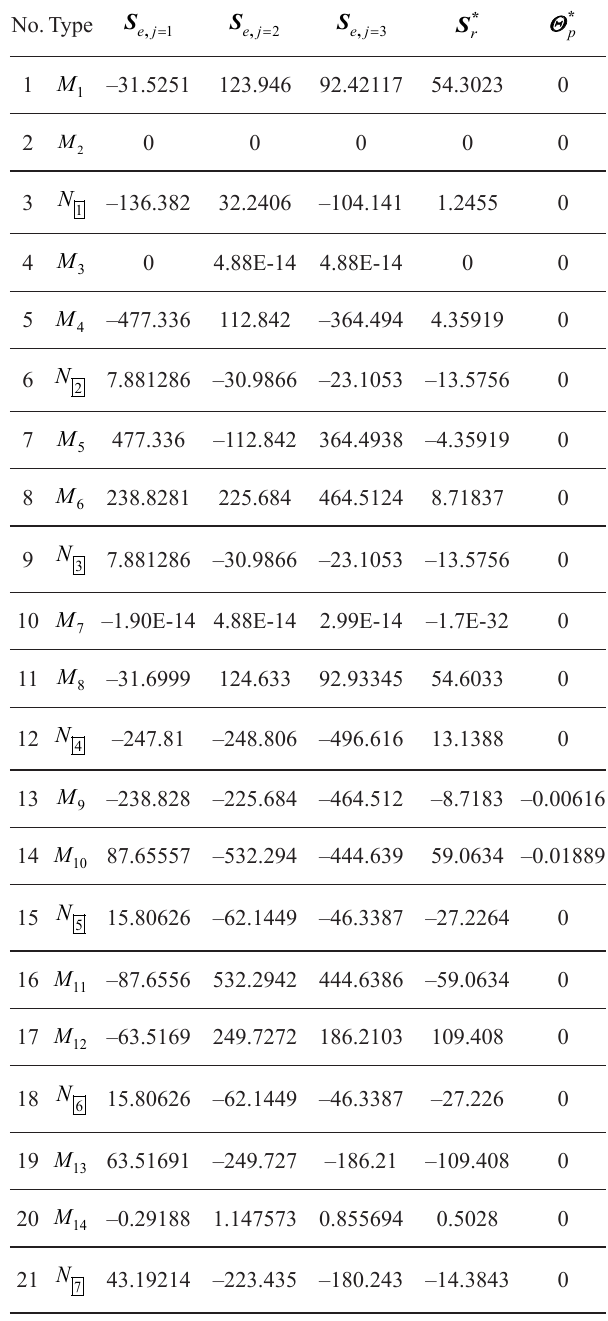
Table 1. Elastic internal forces for each apex of load locus 1 j = , 2 j = , 3 j = and results of problem (7)–(9) for frame shown in Figure 1 No.